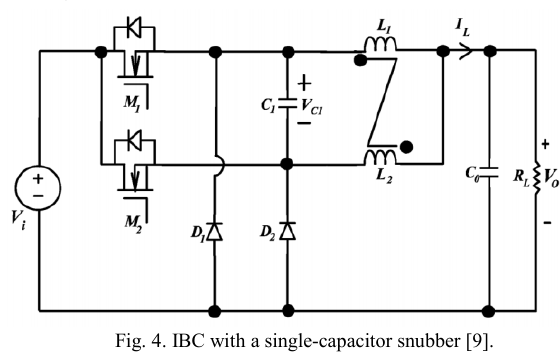
Fig. 4. IBC with a single-capacitor snubber